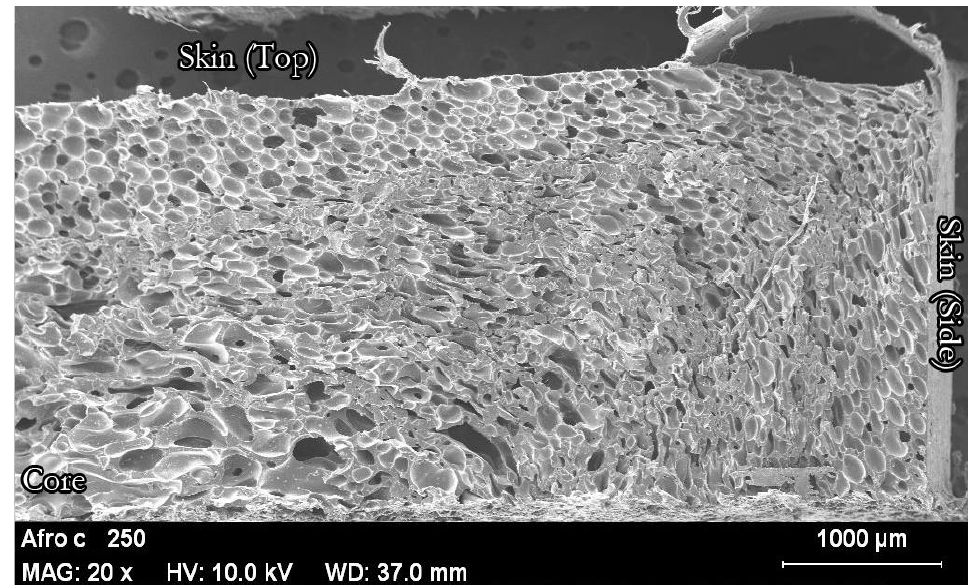
Figure 13. Sample with a relative density of 0.2 and produced with 10.5% of azodicarbonamide. Near the skin the cellular structure shows a regular structure. 500µm from the skin, several cells are crushed in the direction from the core to the skin. In the core, the cells are four times larger than in the skin.